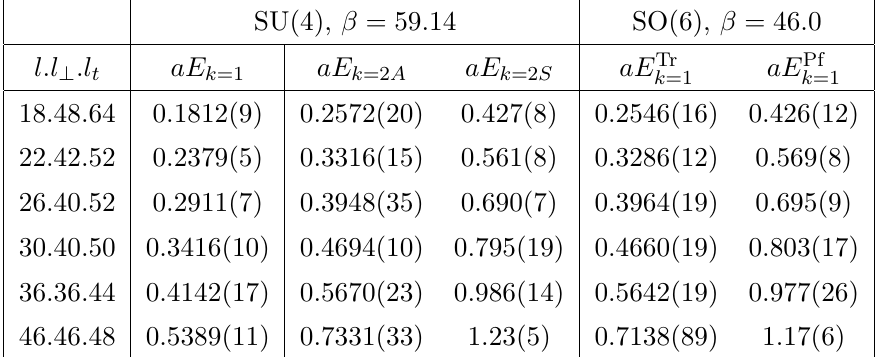
Table 8 . Energy of lightest (cid:13)ux loop of length l in the Trace and Pfa(cid:14)an sectors for SO(6) and in the k = 1, k = 2 A and k = 2 S sectors for